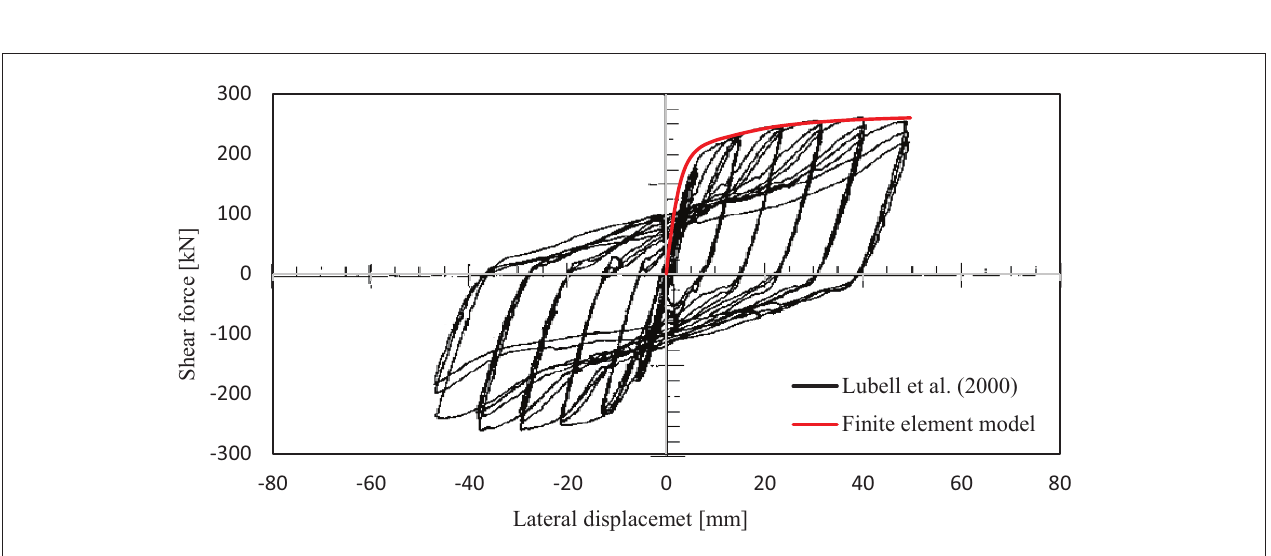
FIGURE 5 | Comparison of the pushover analysis with experimental results.